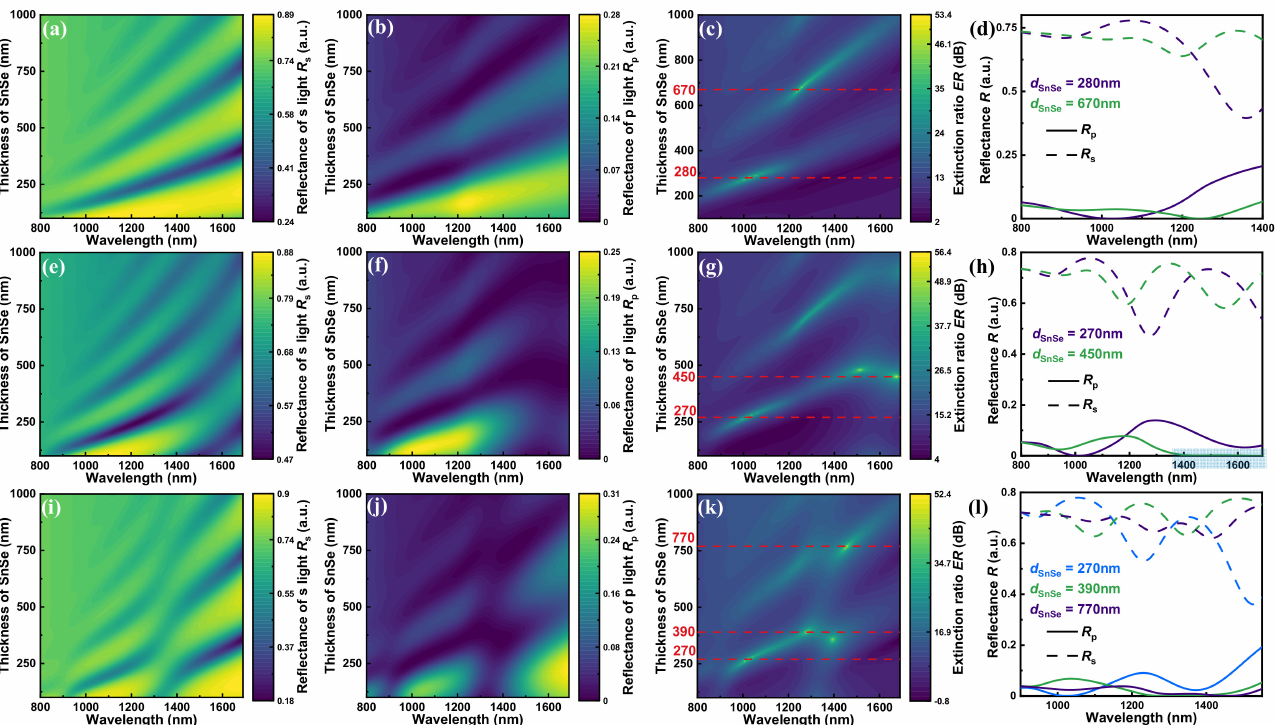
Figure A2. The contour maps of s and p light’s reflectance R s and R p and extinction ratio ER varied with the thicknesses of SnSe, selecting the the representative thicknesses of SnSe layer corresponding to the maximum extinction ratio ER max to show their R s and R p , respectively corresponding to the SiO 2 ’s thickness of ( a − d ) 250, ( e − h ) 750, and ( i − l ) 1250